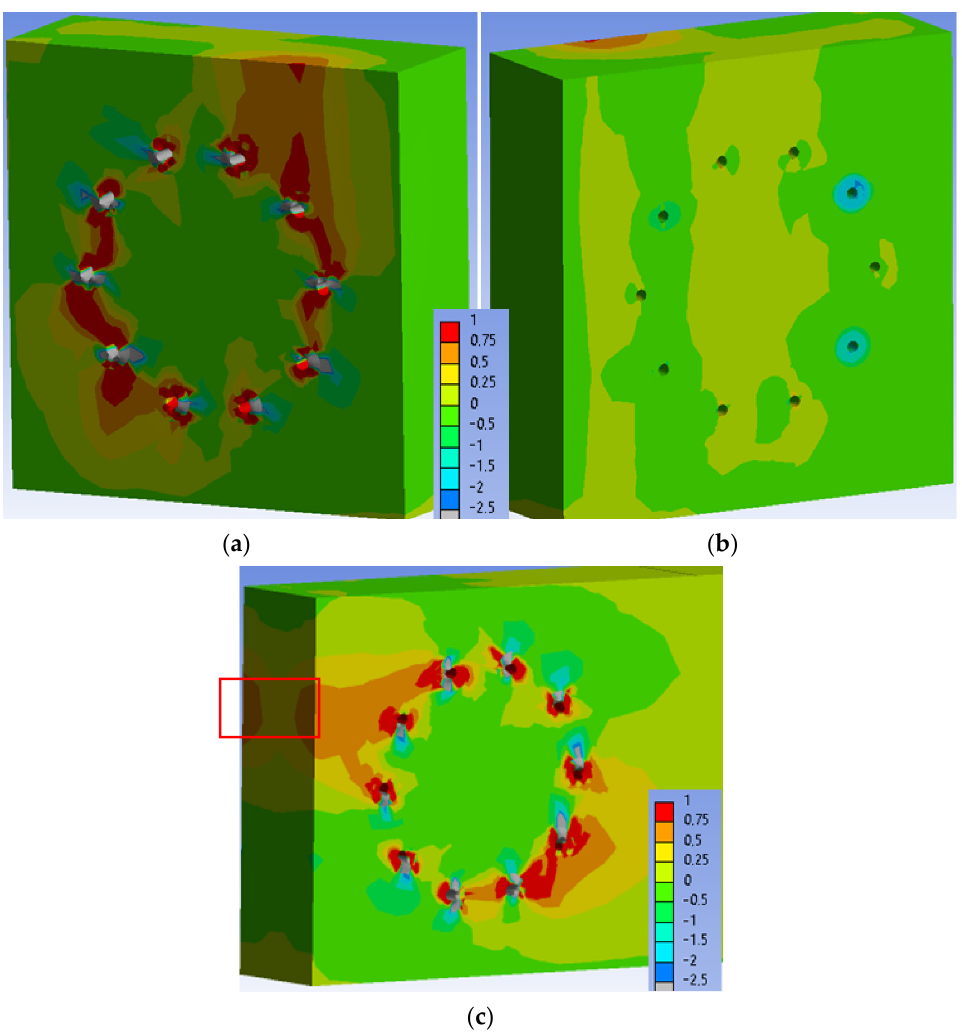
Figure 25. Tensile stress perpendicular to the grain [MPa] at 100% ULS, Experiment A: ( a ) inner side of the stand; ( b ) outer side of the stand; ( c ) rung. Table 12. Results of quasi-static cyclic numerical modeling for Experiment A at 60%